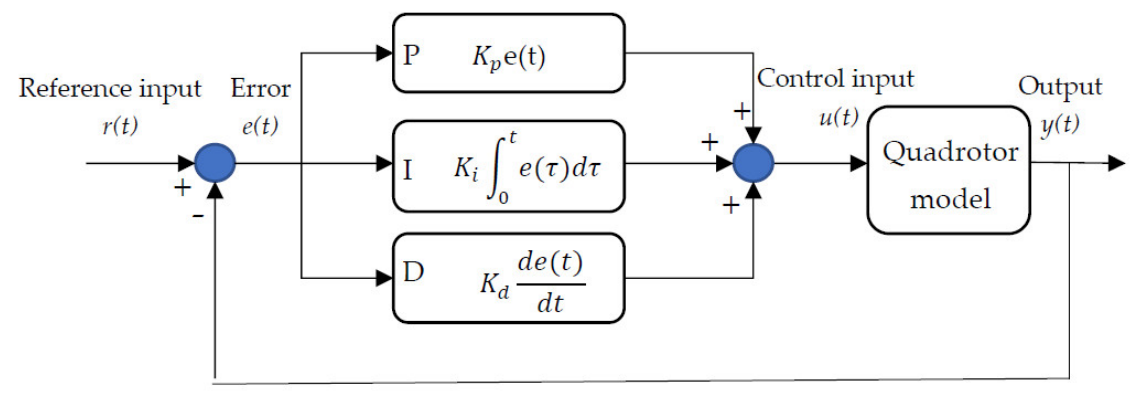
Figure 15. Block diagram of a PID controller.